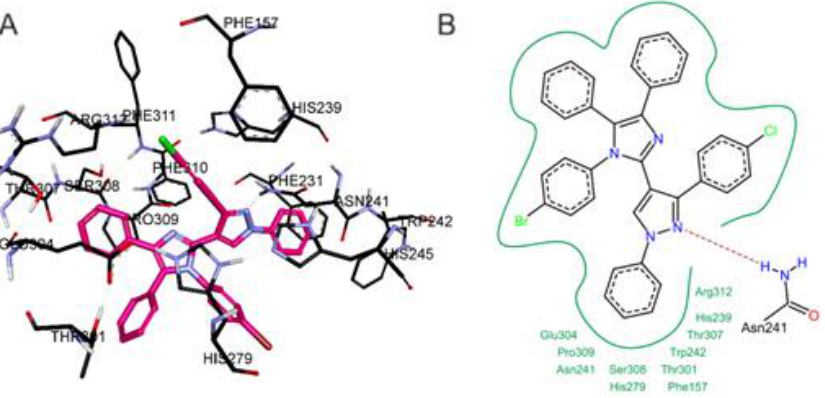
Figure 11. ( A ) The overall structure of the oligo-1,6-glucosidase (PDB ID: 3A4A) from Saccharomyces cerevisiae with compound 145f , and ( B ) 2D interactions for compound 145f . Image adapted from Chaudhry et al. [138].